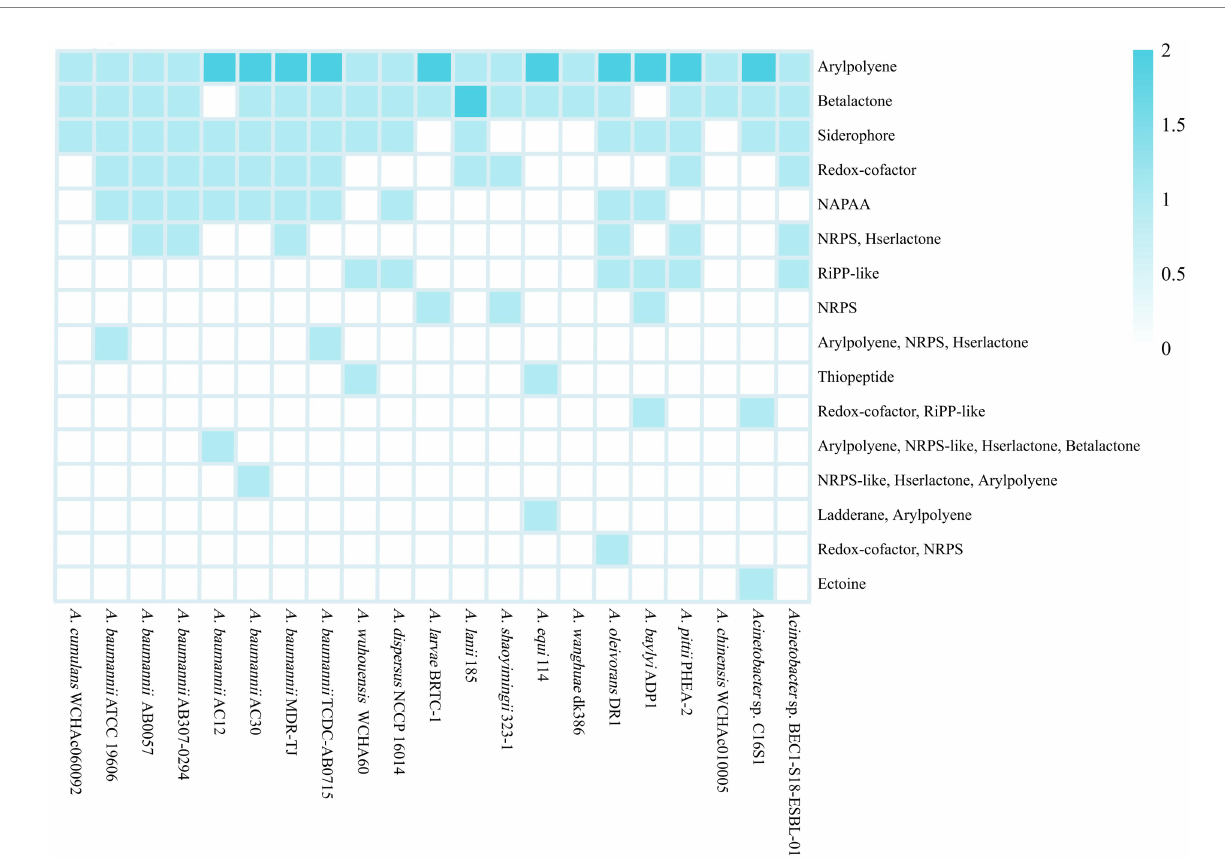
FIGURE 4 Distribution of the smBGCs in 21 Acinetobacter complete genomes. NAPAA, non-alpha poly-amino acids; NRPS, non-ribosomal peptide synthetase cluster; RiPP, ribosomally synthesized and post-translationally modified peptide product